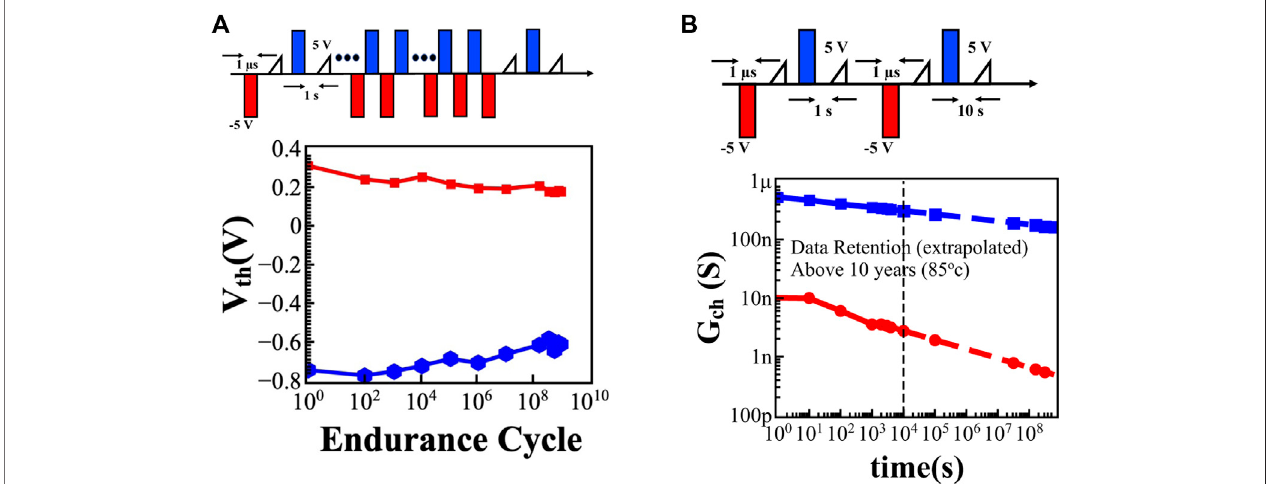
FIGURE 6 | (A) Endurance characterization conducted by ± 5 V pulse of 1 µs width shows excellent performance up to 10 9 cycles. Further reduction of amplitude andwidthof WRITE pulsescanimprovetheWRITEendurance(Deetal.,2021b). (B) Enduranceandretentioncharacteristicsarealwayscountercomplimenting. WRITE pulses of lower amplitude and width always engender good endurance characteristics but they result in poor retention. Therefore, optimization of the pulse scheme is necessary to create a balance between endurance and retention characteristics. The retention characteristics, measured at 85 ° C, show up to 10 4 s, illustrate excellent extrapolated data retention over 10 years with the same pulse amplitude and width used to measure the endurance.